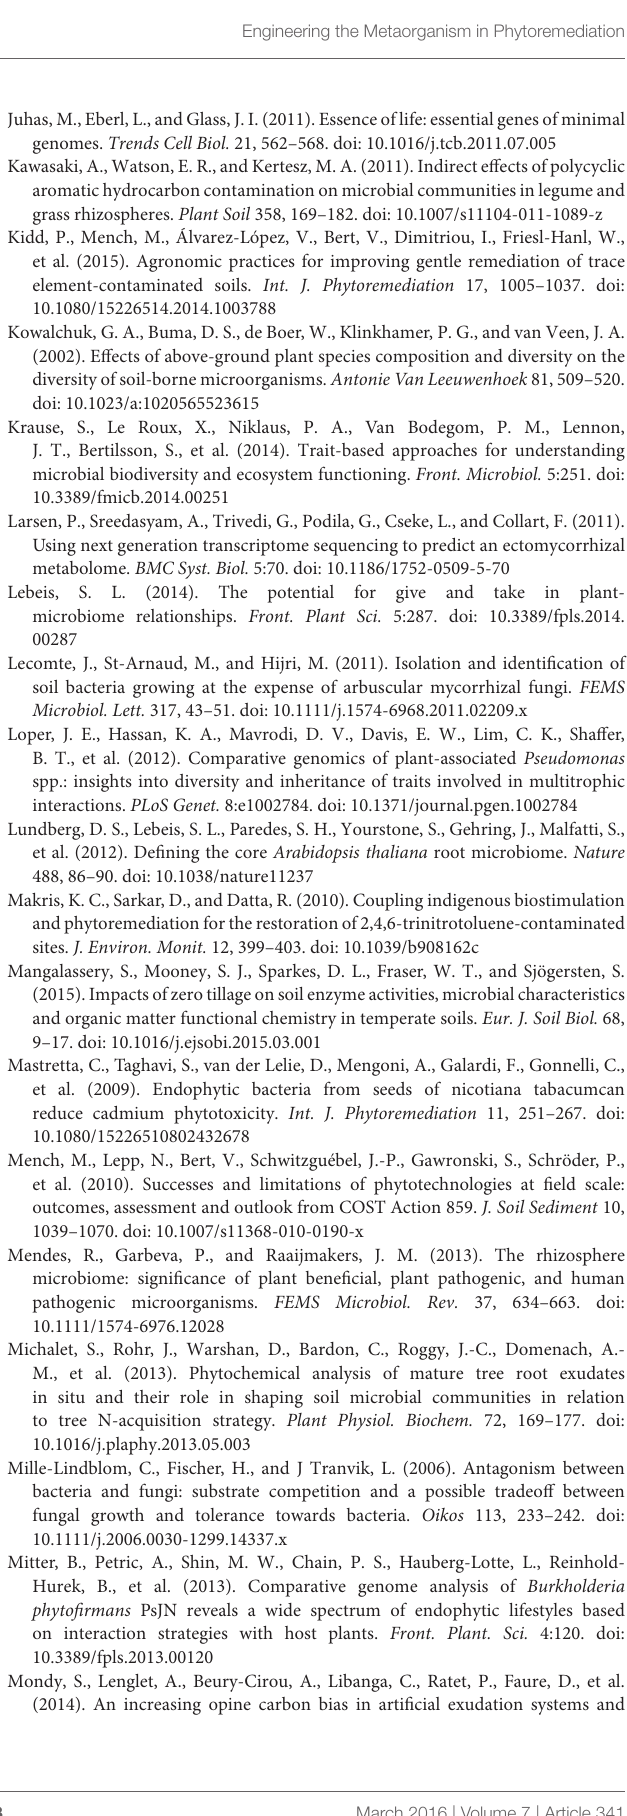
Frontiers in Microbiology |